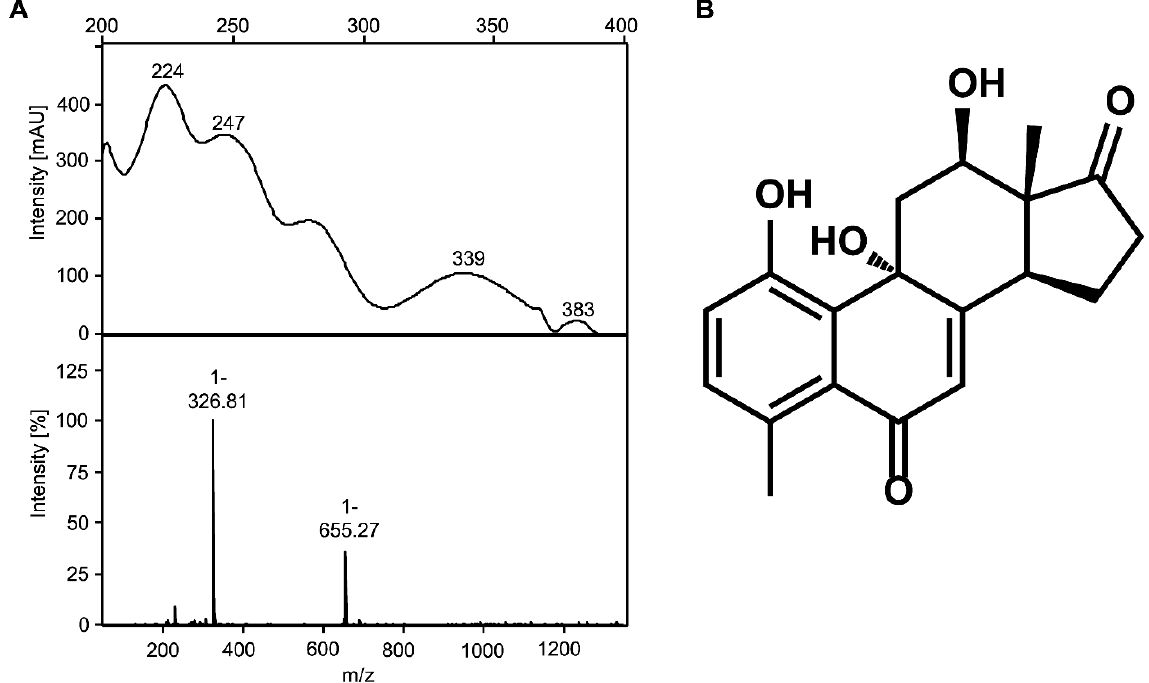
Figure 4. ( A ) UV (top) and mass (bottom) spectra of purified MDTETD. ( B ) Structure of MDTETD according to NMR spectroscopy; chemical shifts are listed in Table S1.